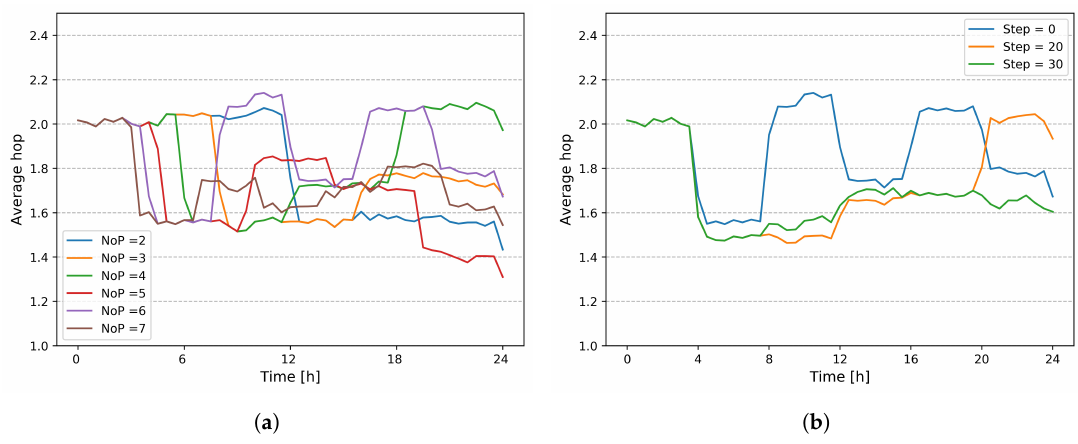
Figure 14. Impact of dynamic parameters on model performance. ( a ) Impact of period T on model performance; ( b ) Benefit of estimated view ( Model with NoP =